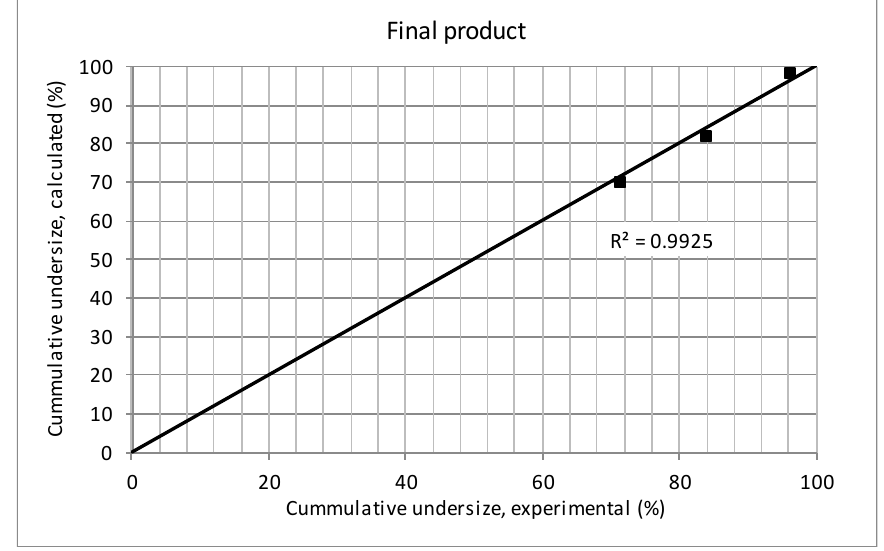
Figure 8. Zero error graph of the experimental data and the data simulated by the SWEF.